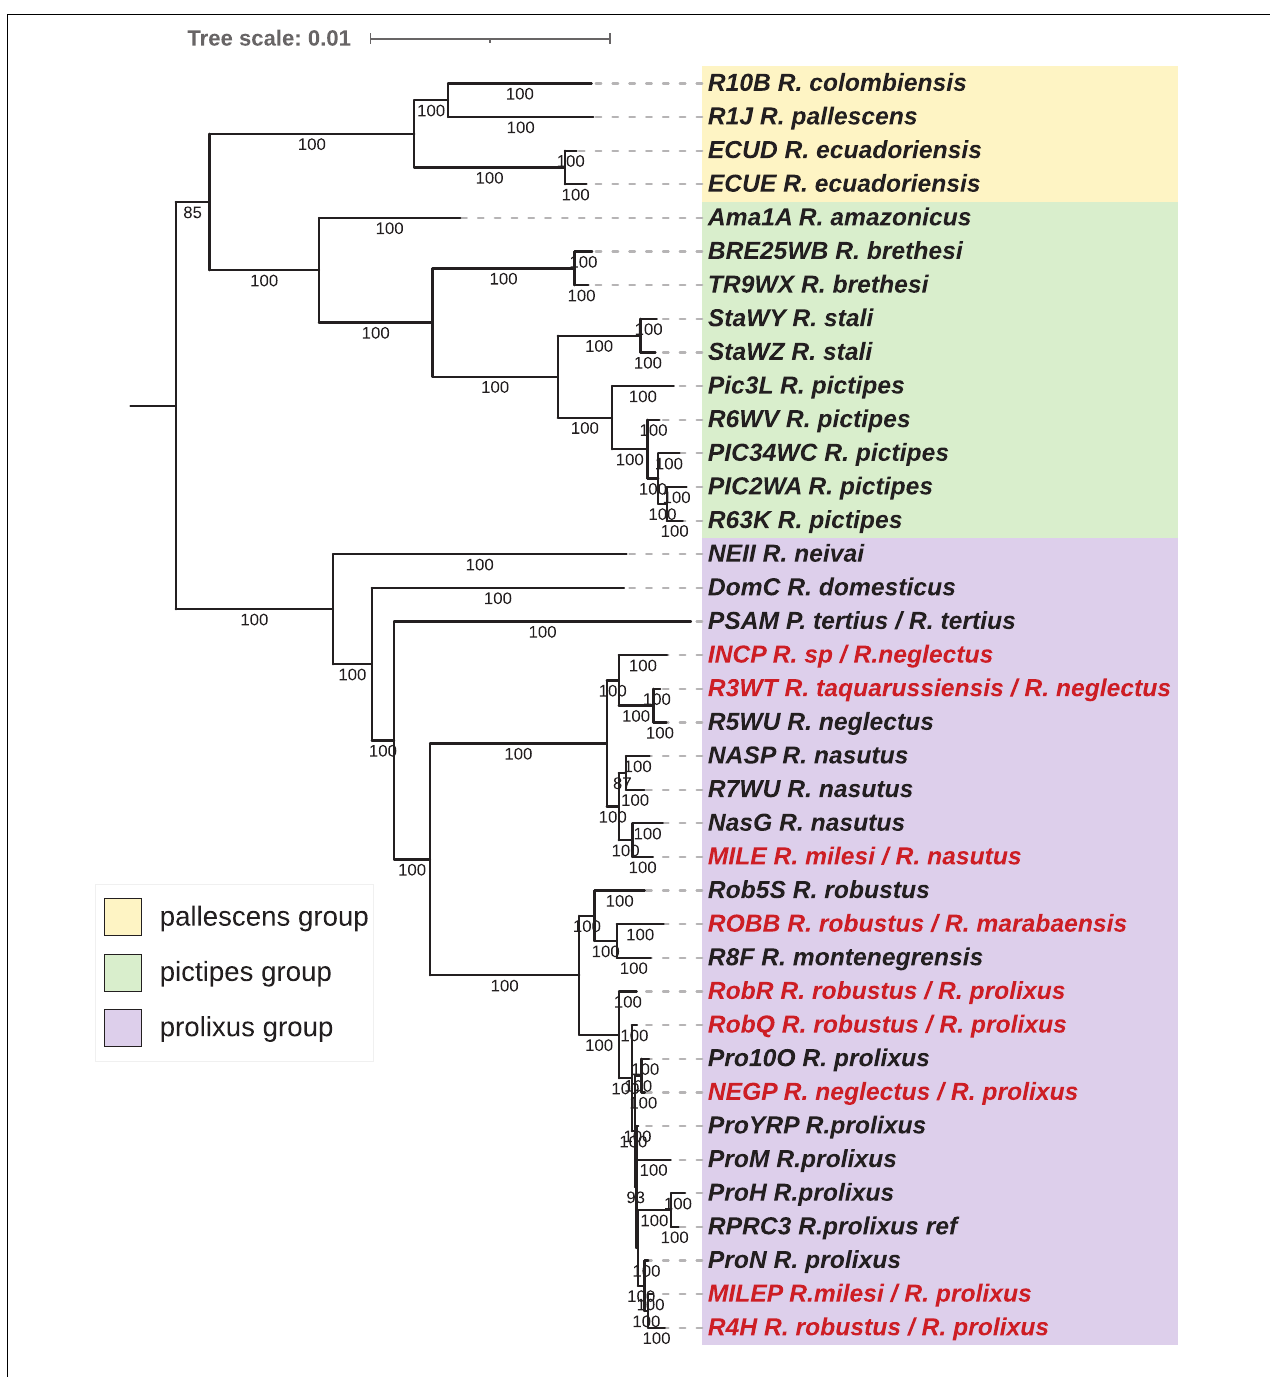
FIGURE 6 | Phylogenetic inferences for the concatenated nuclear protein-coding gene (nu-PCGs) dataset for Rhodnius species using Bayesian Inference (BI) method. The statistical supports (specify Bayesian posterior probabilities in percent) are indicated on the branches. T. brasiliensis was used as outgroup. Misidentified species are indicated in